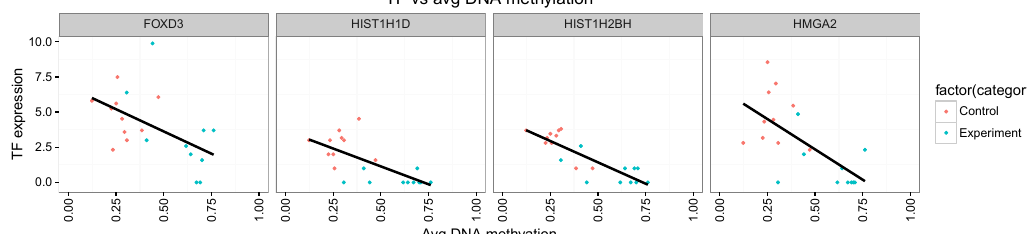
Figure 19. Each scatter plot shows the average DNA methylation level of sites with the FOX motif plotted against the expression of the TFs FOXD3, HIST1H1D, HIST1H2BH, HMGA2 respectively.